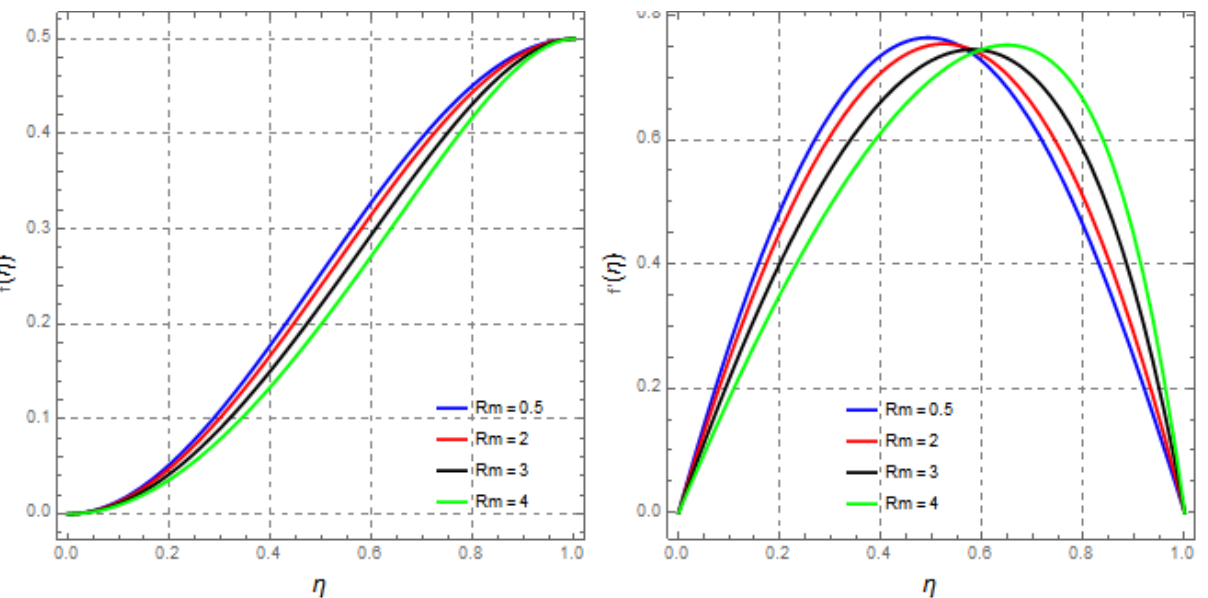
Figure 13. Impact of magnetic Reynolds number R m on velocity component f and f (cid:48) , keeping S z = − 1.5, M x = − 1.5, M y = 3, and S = 1.